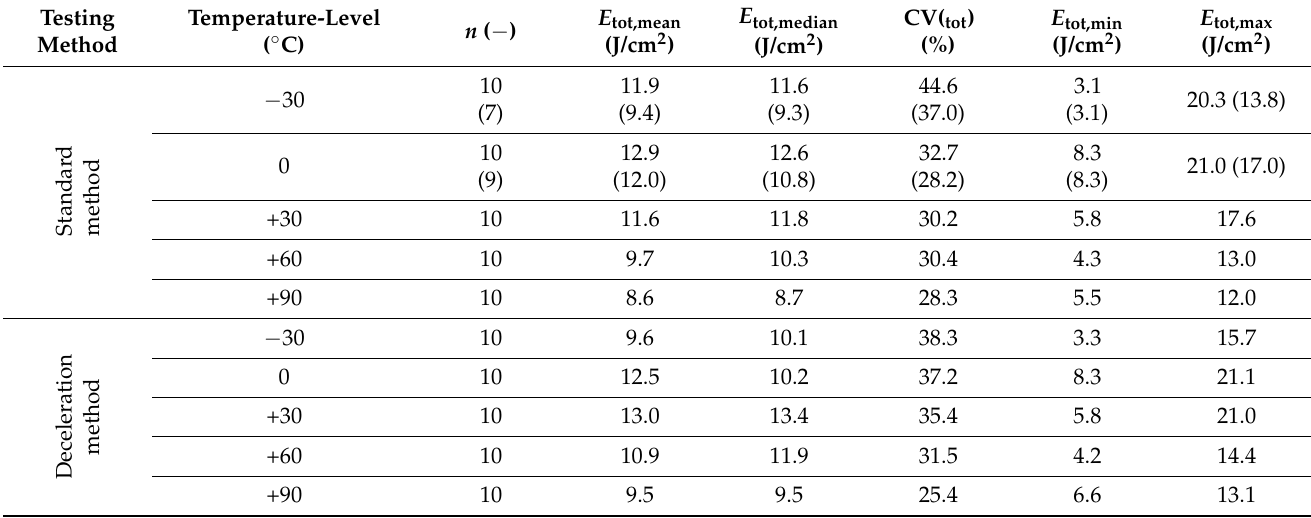
Table A2. Essential statistics of beech according to the standard method and the deceleration method: mean impact bending energy ( E tot,mean ), median impact bending energy ( E tot,median ), coefficient of variation of the impact bending energy (CV( tot )), minimum impact bending energy ( E tot,min ) and maximum impact bending energy ( E tot,max ). Values in parentheses are statistics without invalid